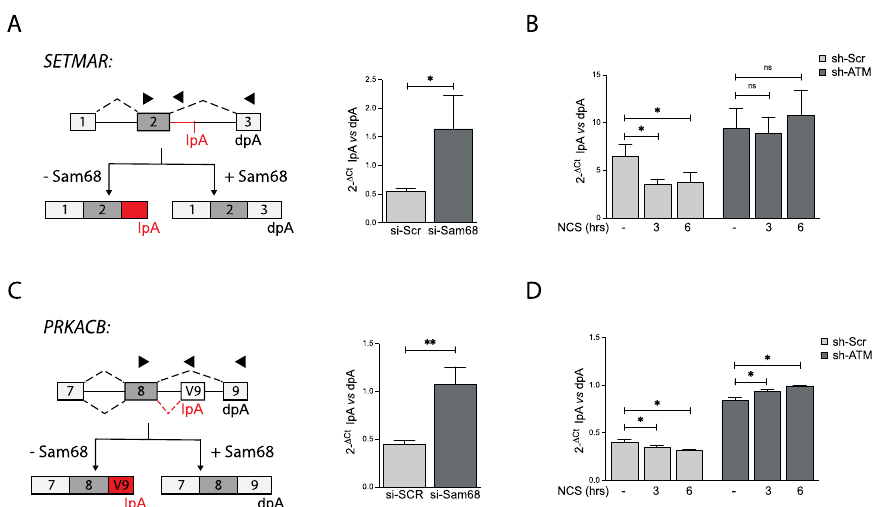
Figure 7. Sam68 APA activity is modulated upon DDR induction in an ATM-dependent way. ( A – D ) Bar graphs showing qPCR analyses of polyadenylation site (pA) usage evaluated in two repre- sentative genes ( SETMAR and PRKACB ) undergoing regulation in cells knocked down for Sam68 (si-Sam68) ( A , C ) or ATM (sh-ATM) and treated, or not, with neocarzinostatin (NCS, 500 ng/mL) for 1 and 6 h ( B , D ). Internal pA (IPA) usage was reported as 2 − ∆ Ct with respect to distal pA (d-pA) (* p < 0.05, ** p < 0.01, n.s. not significant, t test) ( A – D ). A schematic representation of SETMAR and PRKACB alternative polyadenylation events is also shown ( A , C